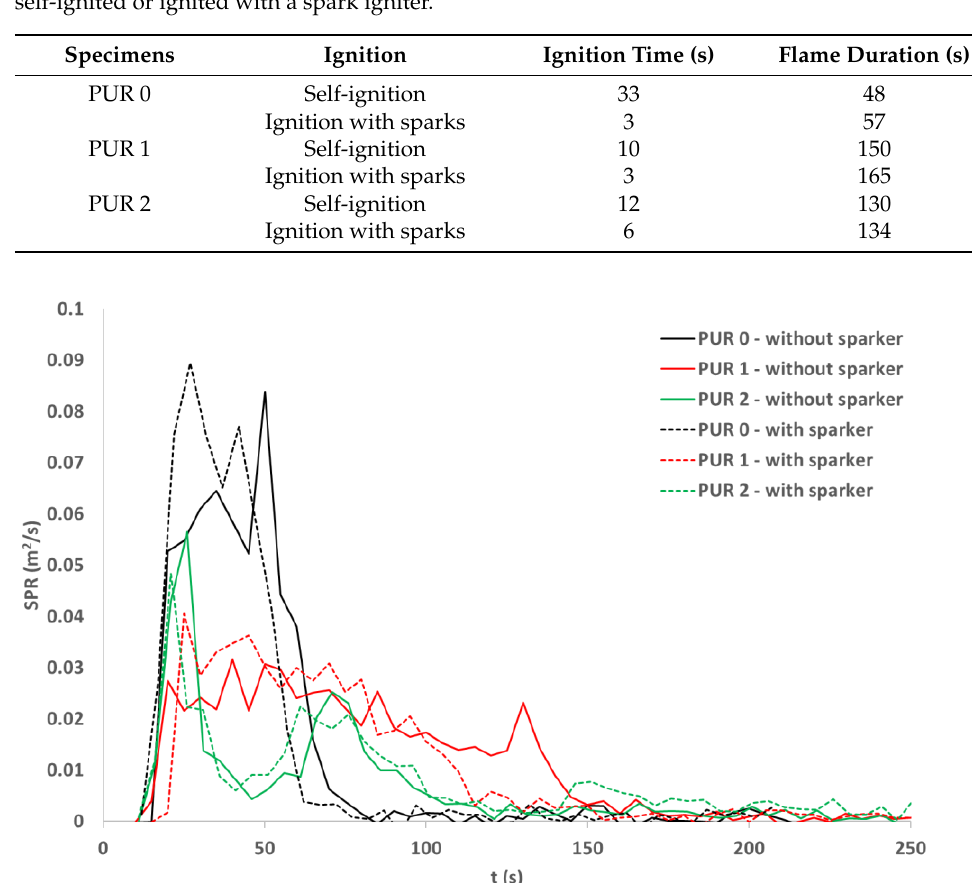
Figure 7. Smoke production rate (SPR) of the PURs samples exposed to the 40 kW/m 2 of heat flux; self-ignition and spark ignition.